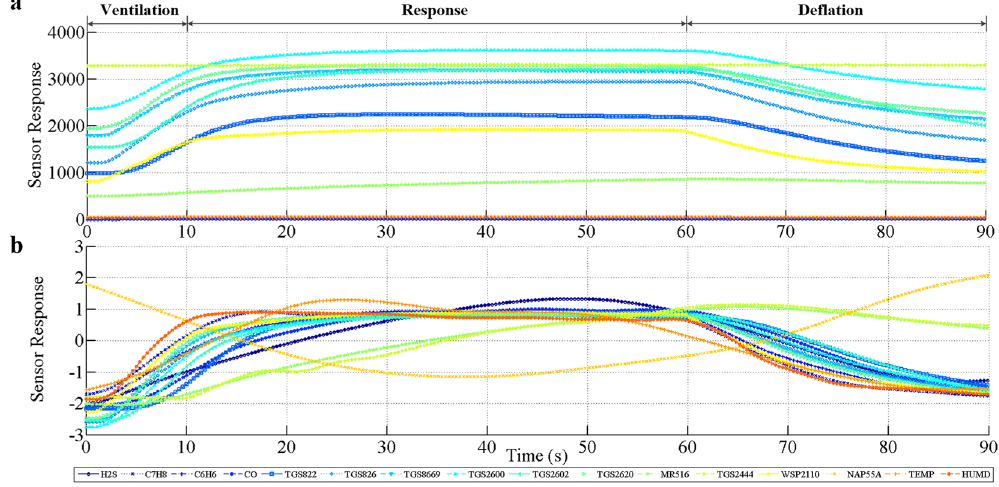
Figure 3. Typical response curves of the sensor arrays. ( a ) Response curves of the sensor arrays before preprocess. ( b ) Response curves of the sensor arrays after